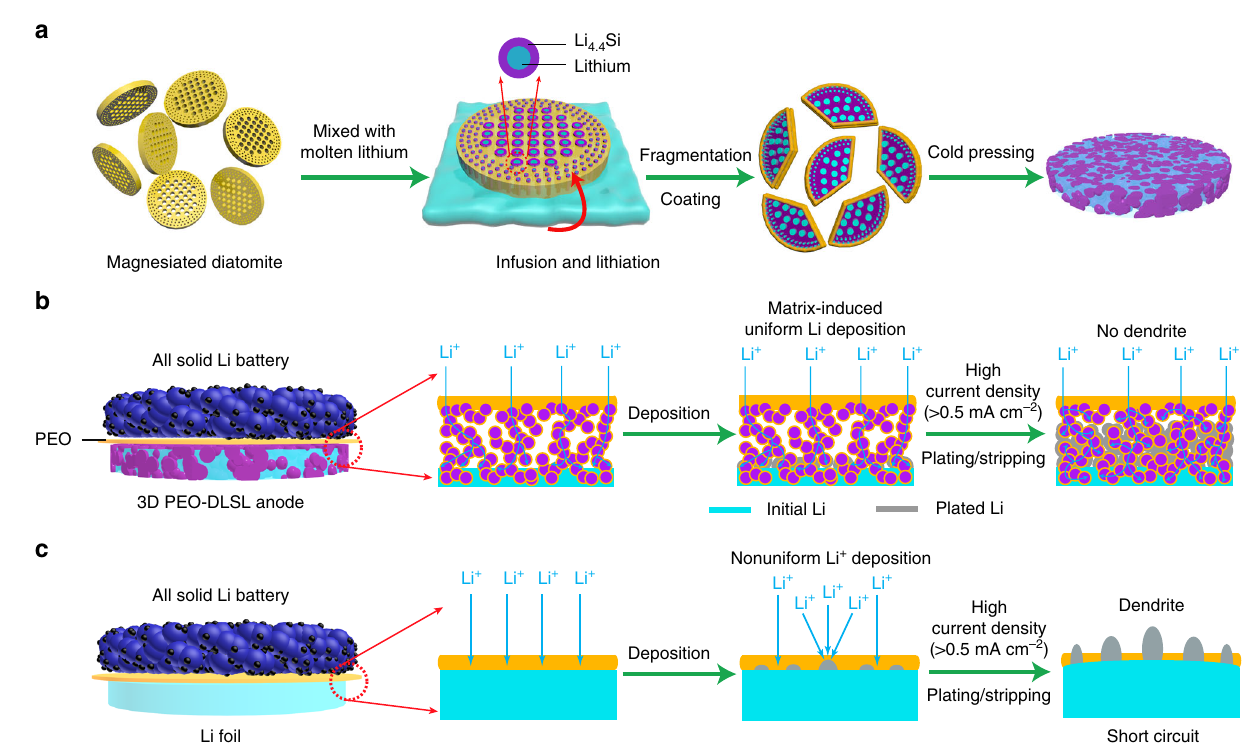
Fig. 1 Schematic illustration of the PEO-DLSL anode fabrication process and Li stripping/plating behaviors in comparison with a planar Li anode. a The fabrication process of PEO-DLSL. The DF-Si powder was mixed with molten Li to form the DLSL fragments and the PEO-DLSL composite anode was fabricated by cold-pressing the DLSL fragments with PEO-SPE coatings. b, c Li stripping/plating behavior in all-solid-state Li metal batteries with PEO-DLSL anode and a planar Li-foil anode, respectively. The effective Li + ion fl ux in PEO-DLSL anode was much more uniform than that in a planar Li foil, leading to a dendrite-free anode without the short